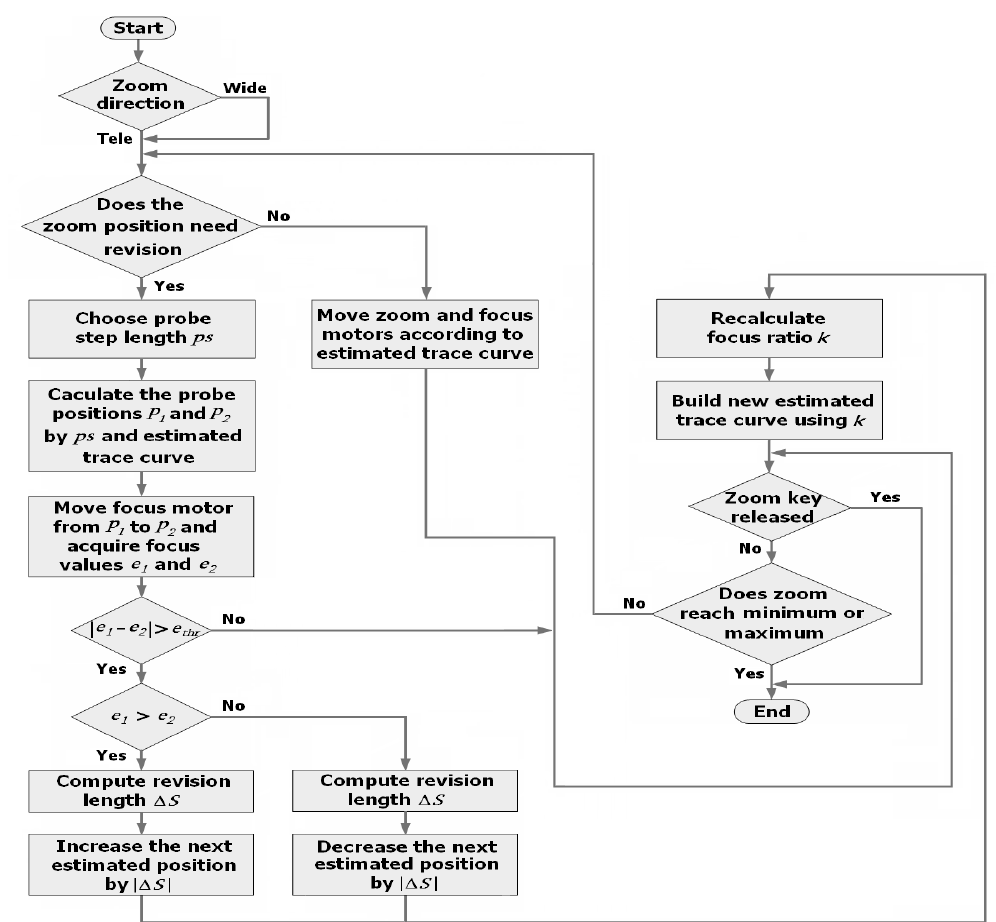
Figure 8. Feedback zoom tracking